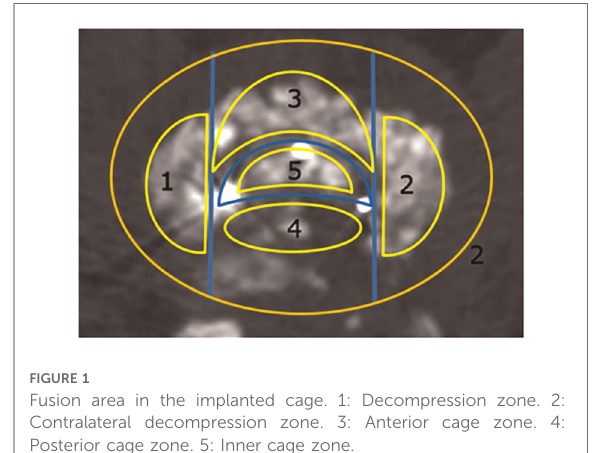
FIGURE 1 Fusion area in the implanted cage. 1: Decompression zone. 2: Contralateral decompression zone. 3: Anterior cage zone. 4: Posterior cage zone. 5: Inner cage zone.